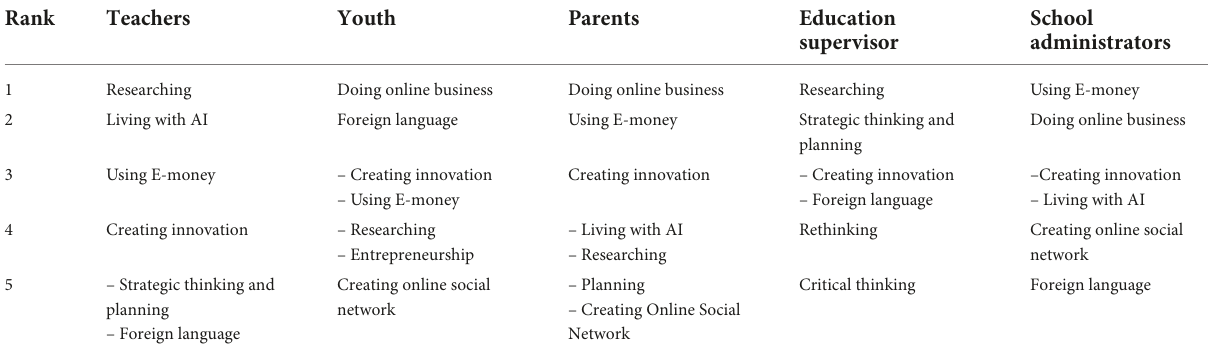
TABLE 4 Comparing skill needs priorities by